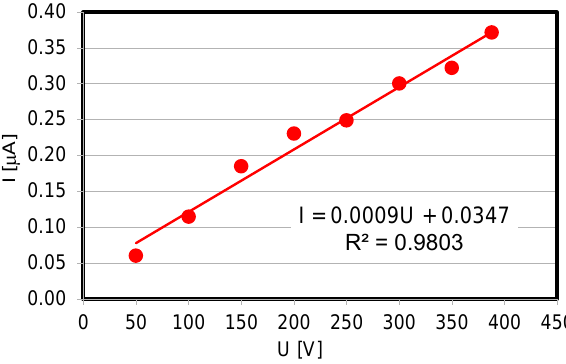
Fig. 7. Impact of the measuring system voltage on the ionization current value (spark plug No. 1)